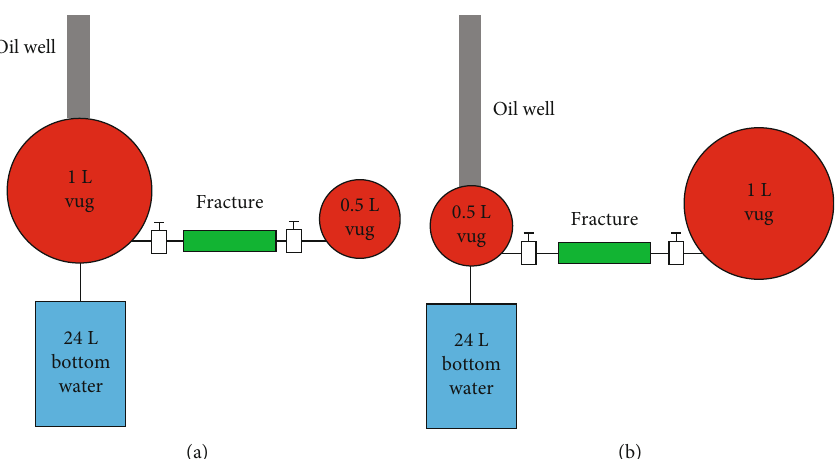
Figure 1: Schematic diagram of the high-pressure physical simulation experiment model for (a) bottom water connected to the large vug and (b) bottom water connected to the small vug.